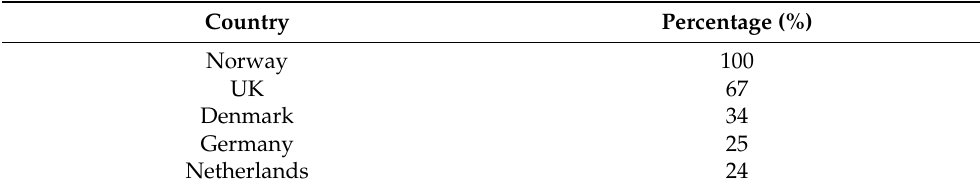
Table 2. Household penetration of DAB+ receivers.